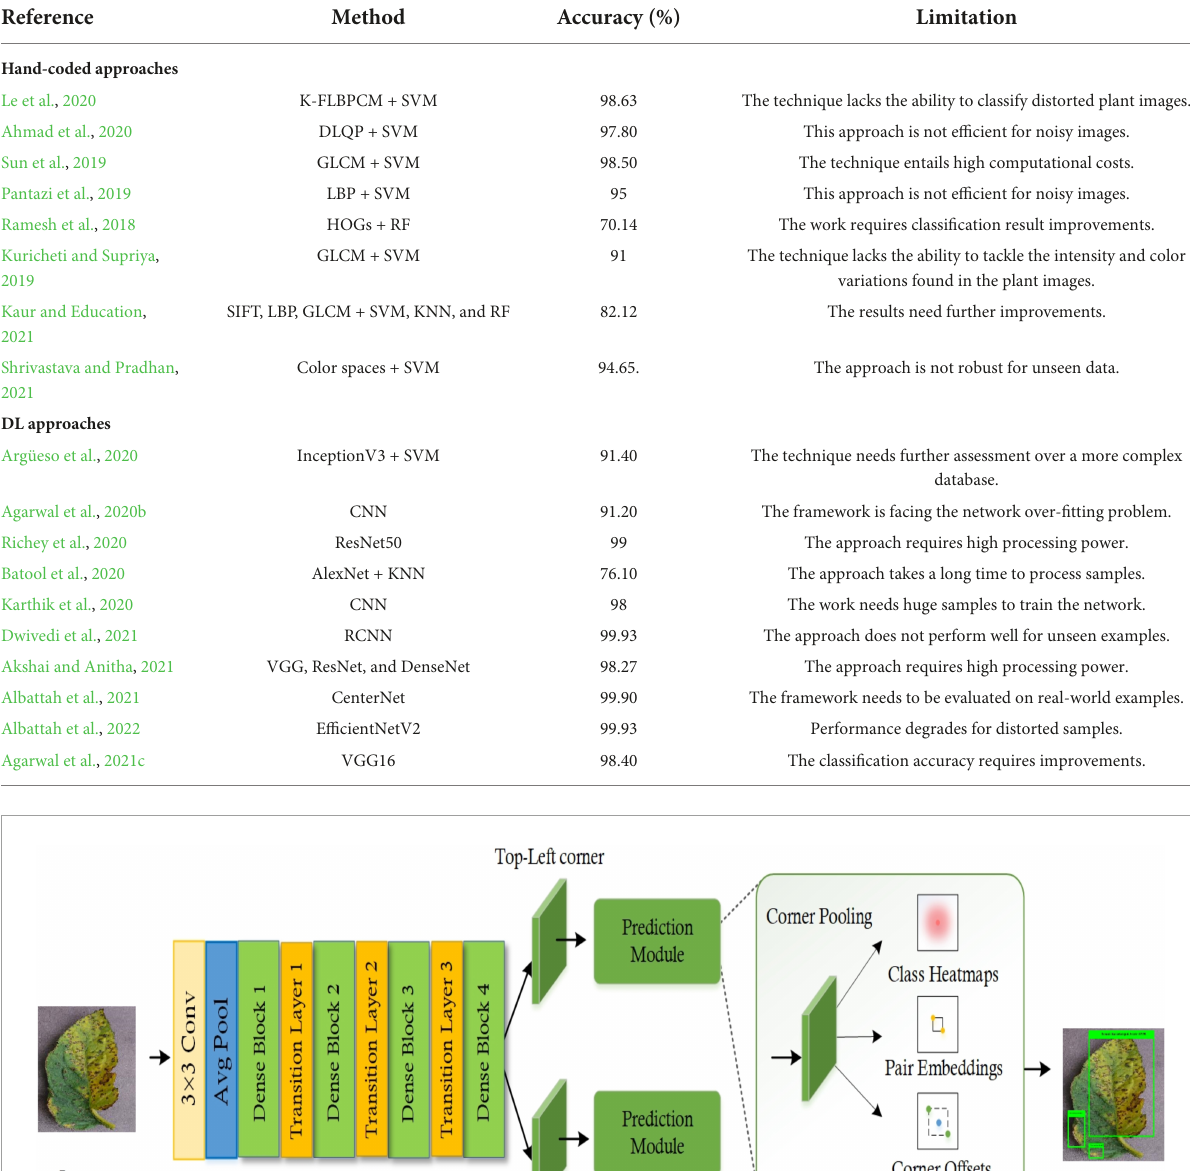
TABLE 1 An analysis of existing methods.